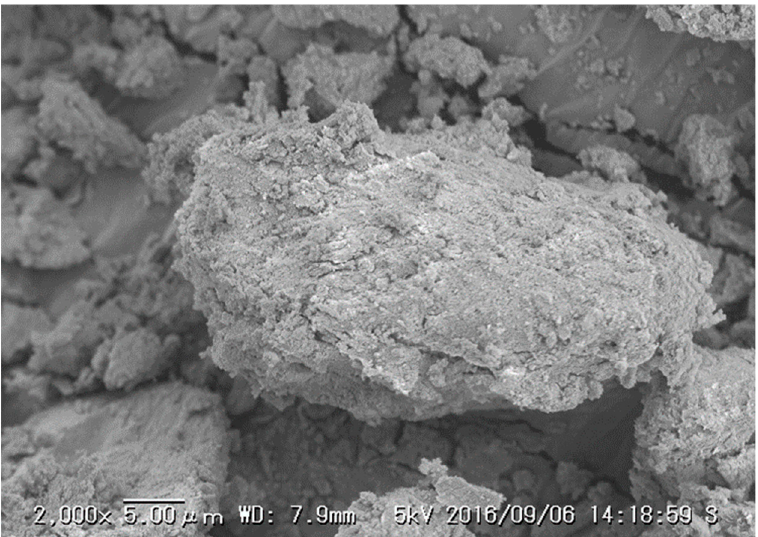
Figure 7. SEM image of the CBC after fluoride adsorption.